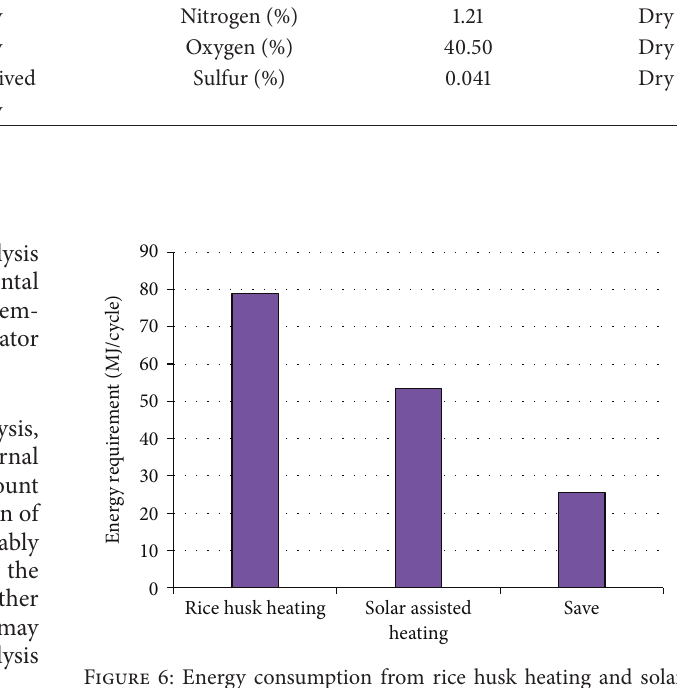
Figure 6: Energy consumption from rice husk heating and solar assisted